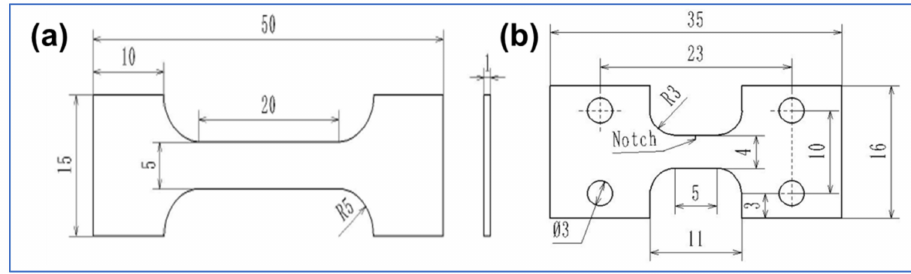
Figure 1. Dimension drawing of alloy (mm): ( a ) extension test, ( b ) in situ tensile test. Samples were firstly solution-treated (solution treatment was defined as HT) for 0.5